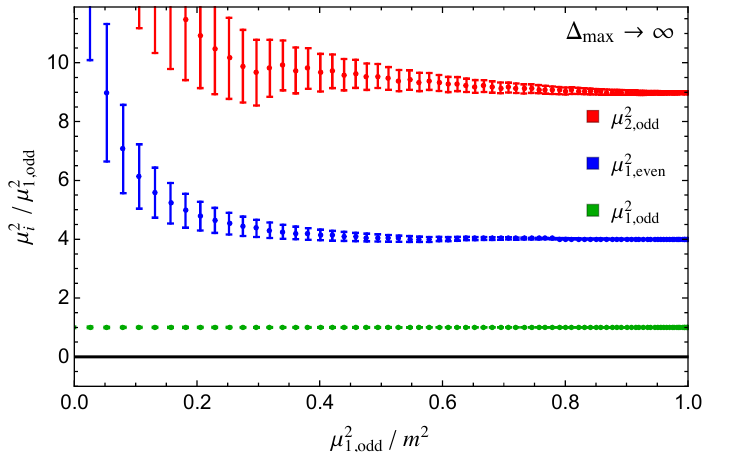
Figure 5 . The ratio of two lowest mass eigenvalues in the odd sector and the lowest eigenvalue in the even sector to the mass gap as a function of (cid:22) 2